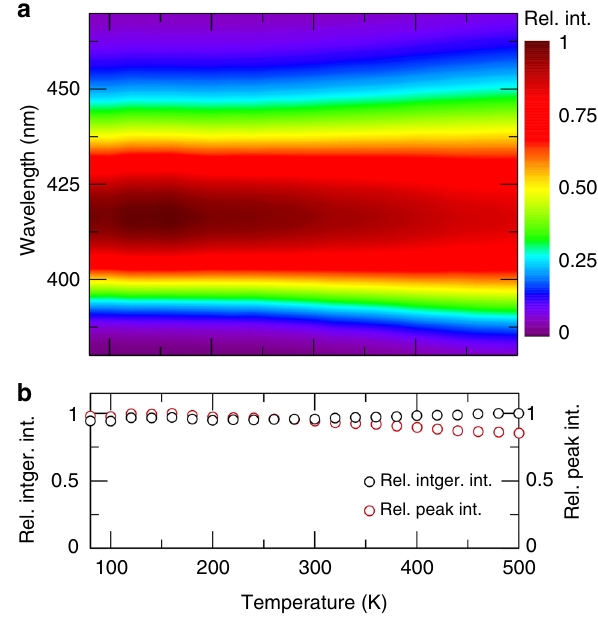
Fig. 7 Temperature-dependent photoluminescent properties of NaBa 0.97 Eu 0.03 B 9 O 15 phosphor. a Contour plot of the normalized emission spectra excited at 340 nm as a function of temperature. b Relative integrated intensity of the emission spectra (rel. intger. int.) and the relative intensity of the emission peak (rel. peak int.) — as a function of